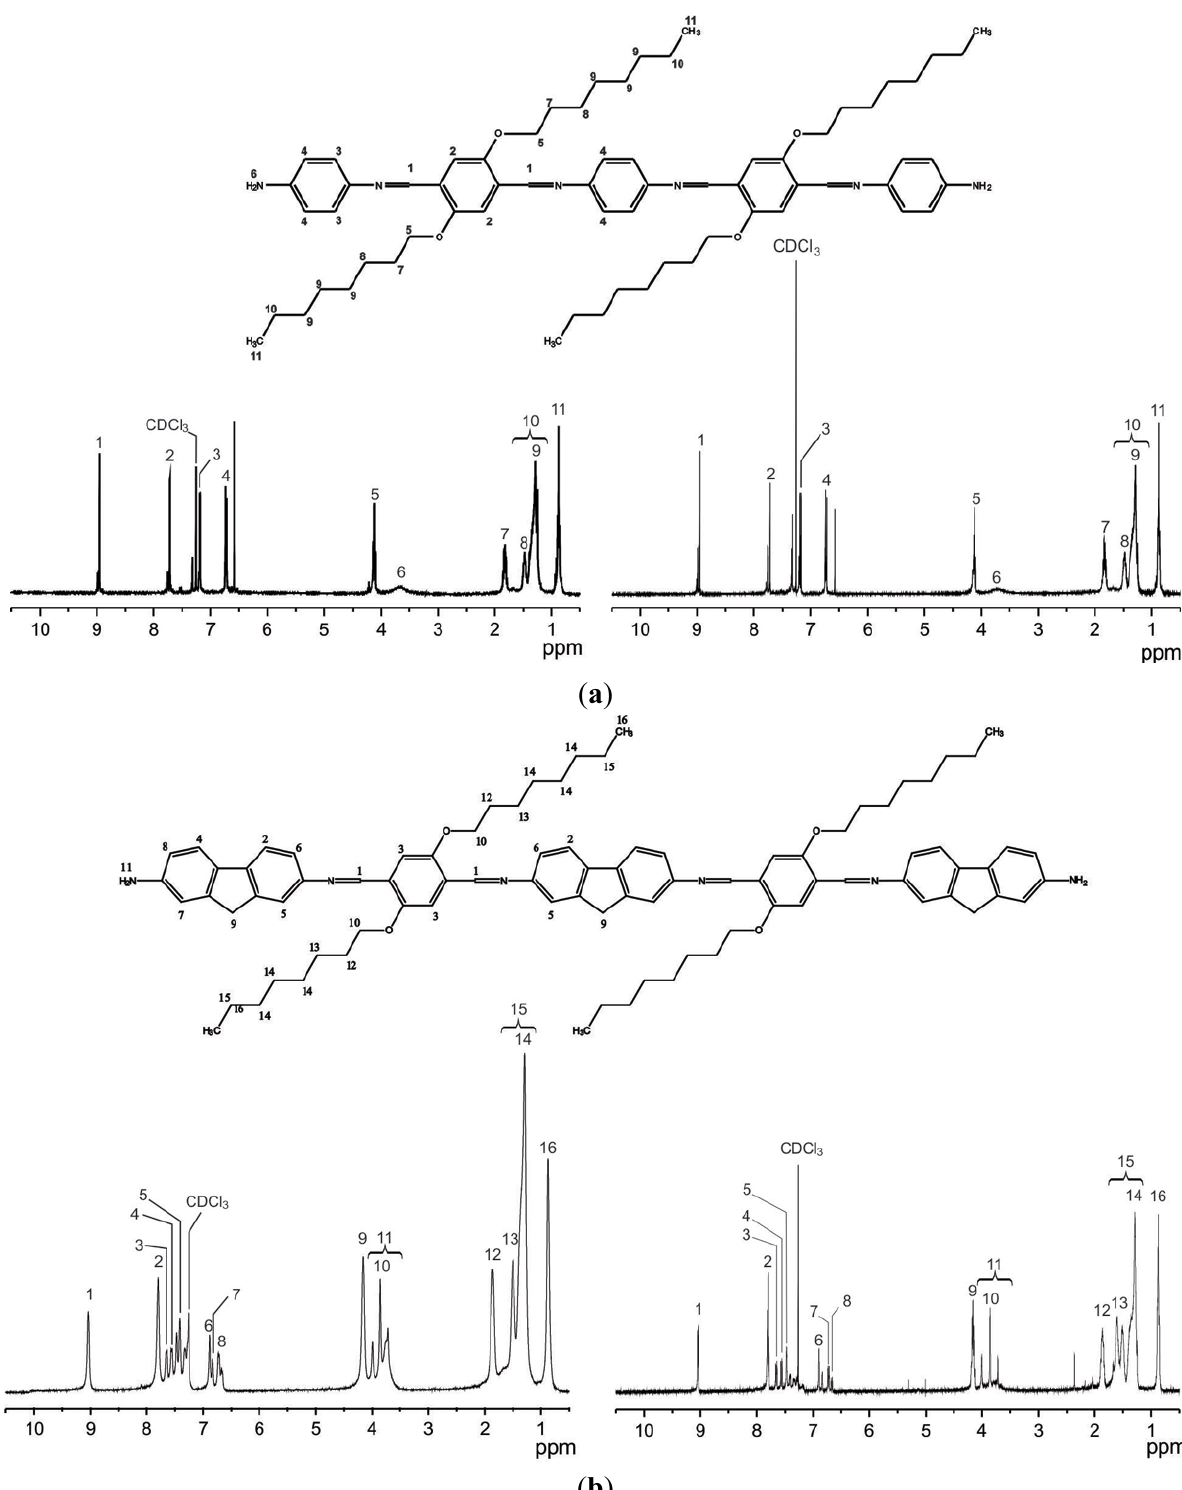
Figure 3. 1 H-NMR of ( a ) OIC1MS ; and ( b ) OIC2MS